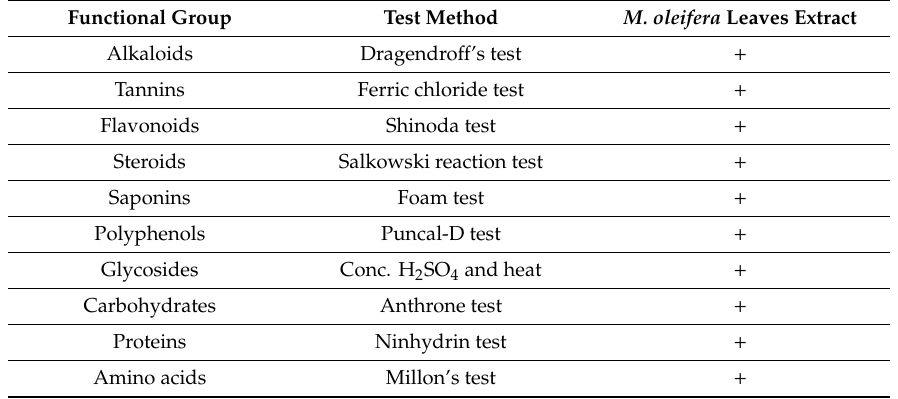
Table 1. Phytochemical analysis of the Moringa oleifera leaves extract. The presence is indicated with ( + ).